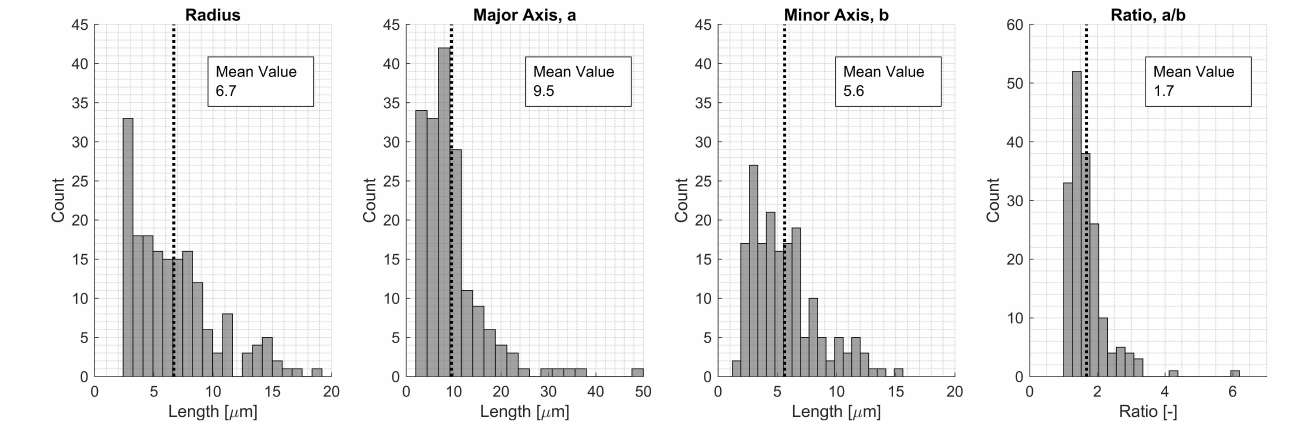
Figure 7. Extracted void data for the manufactured plate looking at shape parameters for a fitted circular and elliptical void shape.